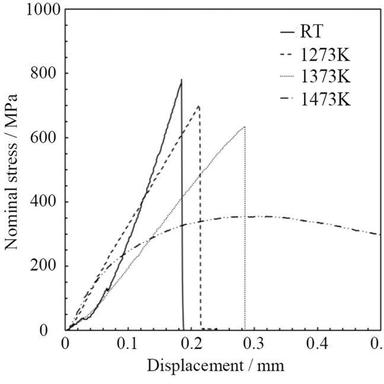
Stress-displacement curves of TiCrNbMoTa specimens at various temperatures obtained via three-point bending tests.